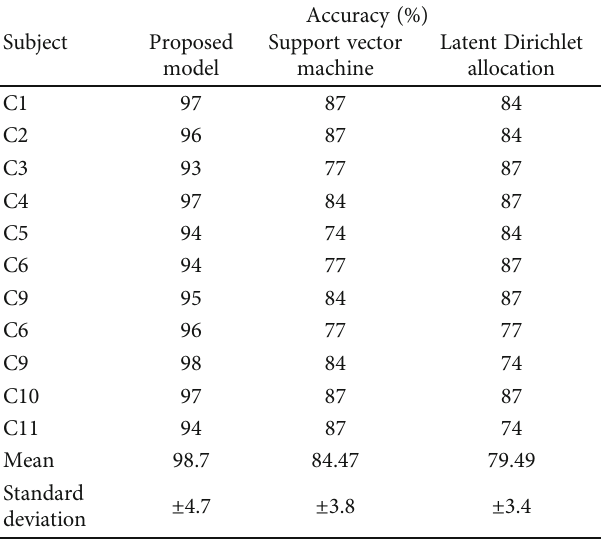
Table 4: Prediction results attained by various tuned